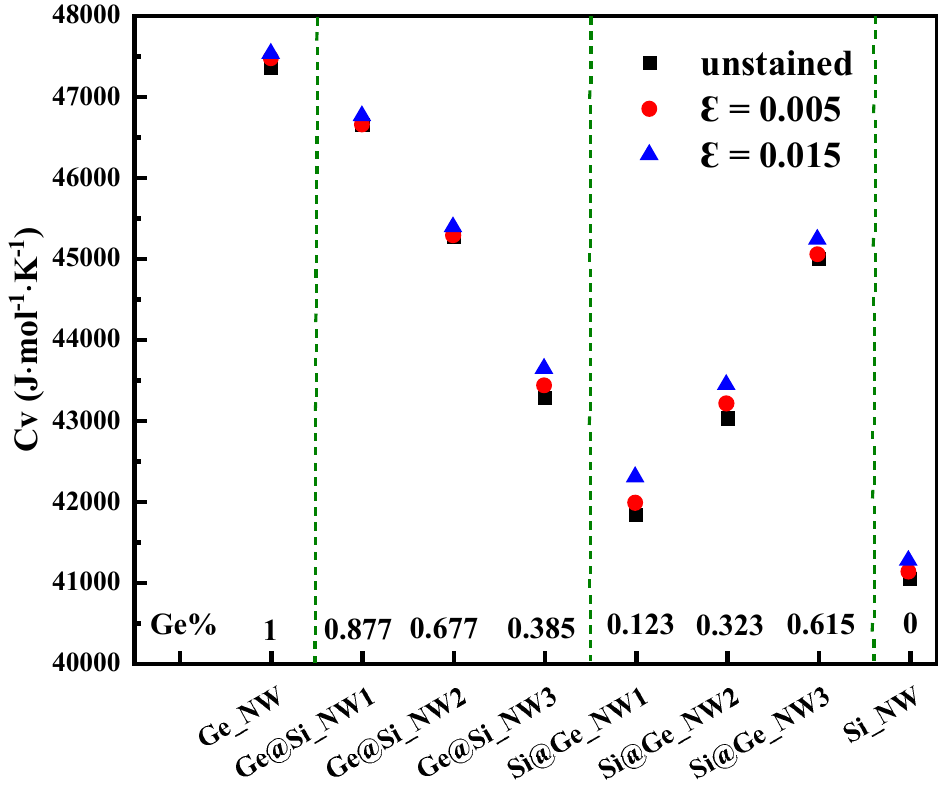
Figure 9. Heat capacity (Cv) of Ge@Si and Si@Ge nanowires with different core–shell ratios at 300 K.